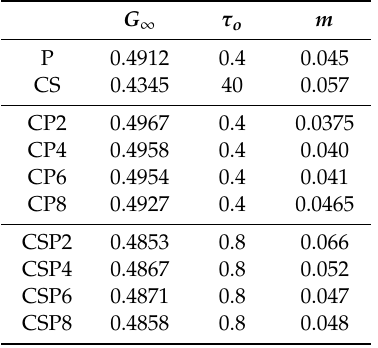
Table 4. Stress relaxation fitting